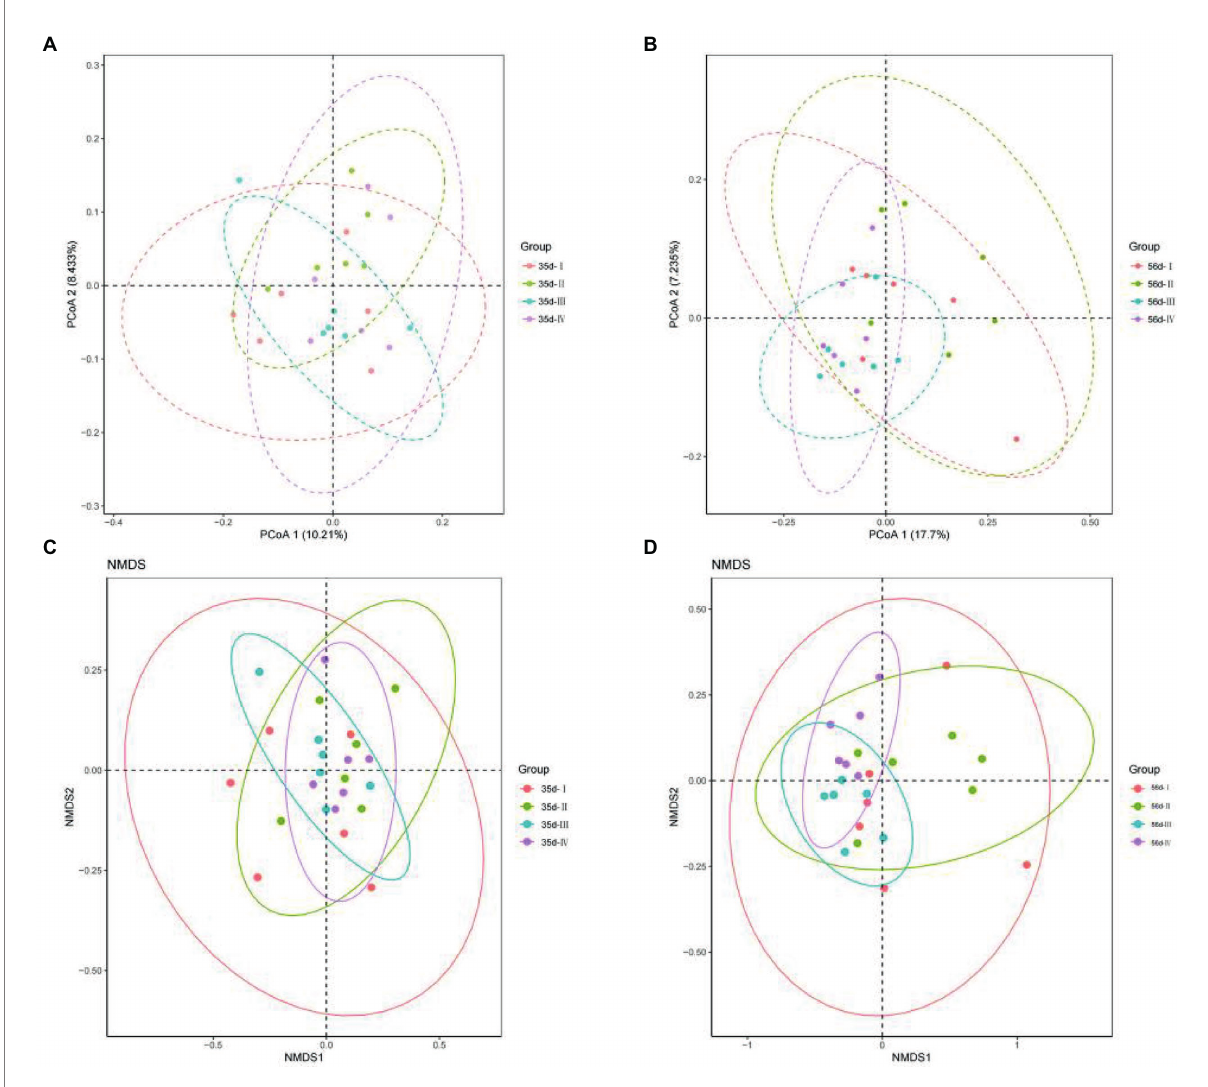
FIGURE 4 The cecal microbial PCoA map and NMDS map of the unweighted UniFrac distance matrix of broilers in different treatment groups. (A) 35 day-PCoA plots; (B) 56 day-PCoA plots; (C) 35 day-NMDS plots; (D) 56 day-NMDS